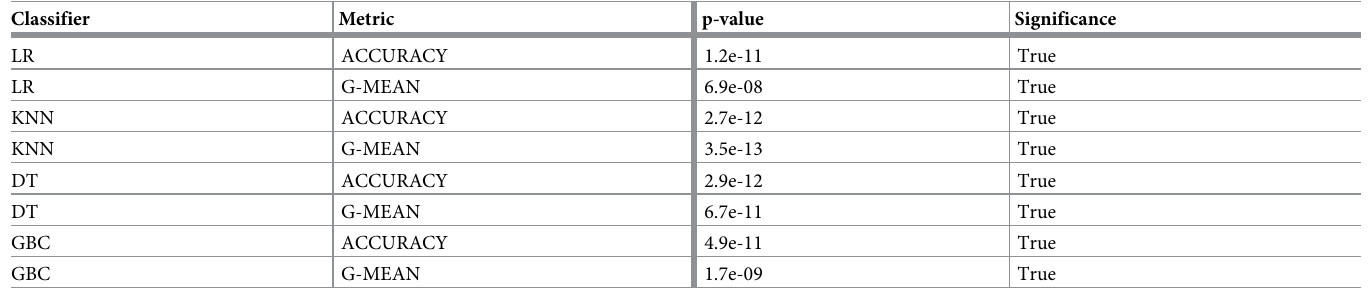
Table 5. Results for Friedman